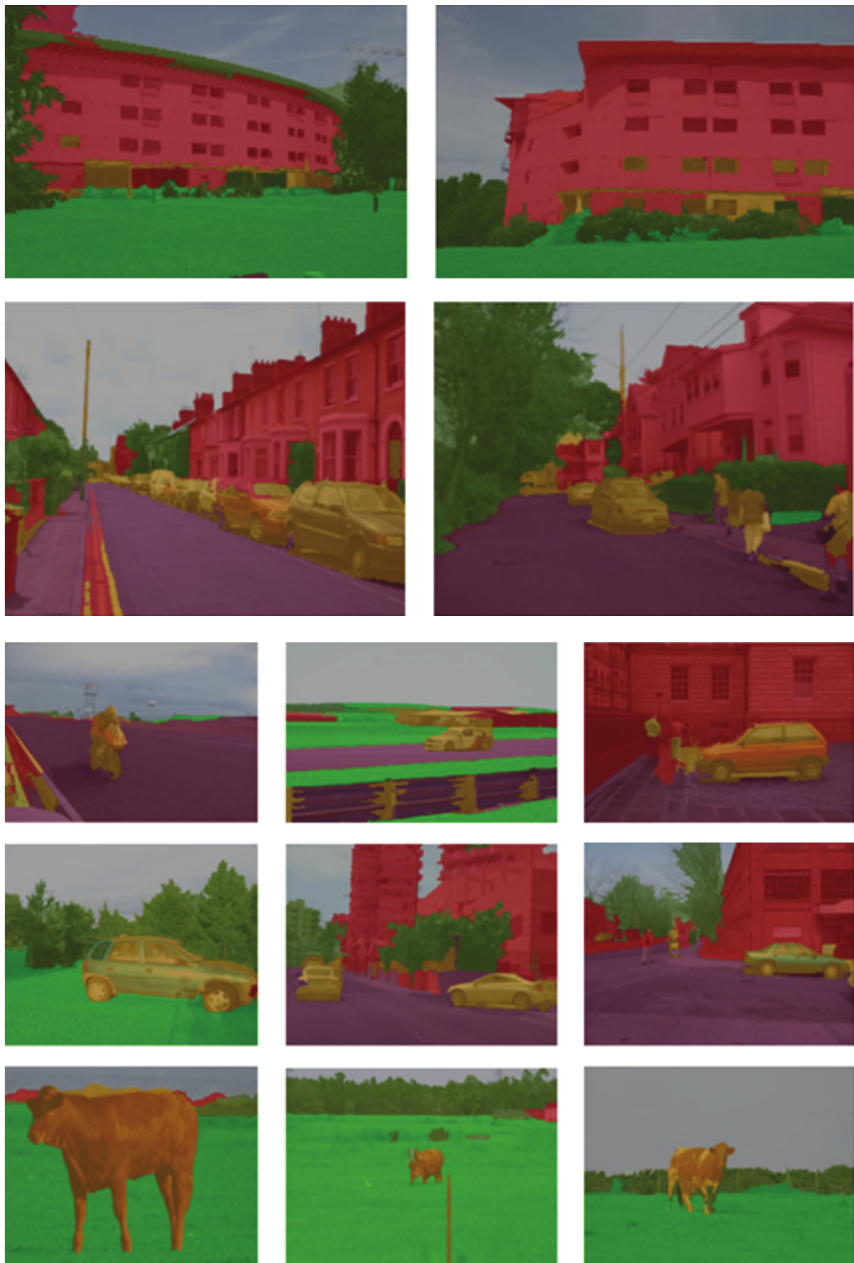
Figure 5: Typical results of multiclass image segmentation and pixel-wise labeling with PSO-based recursive neural networks.